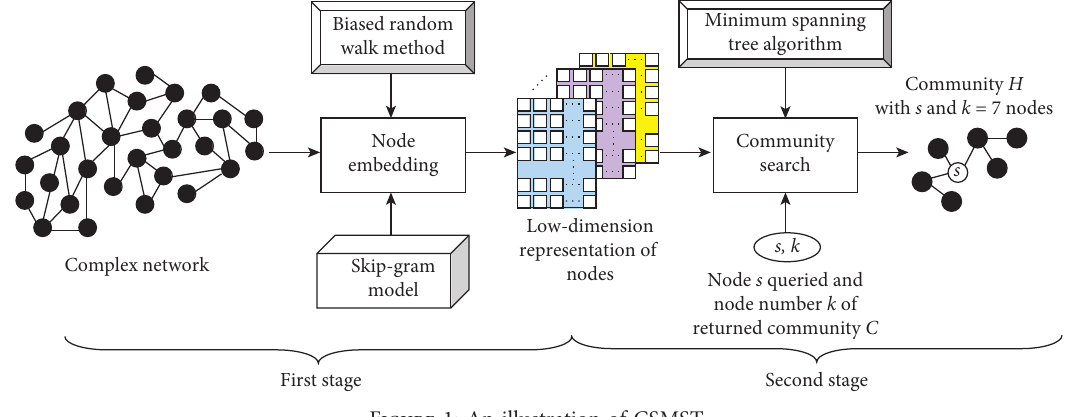
Figure 1: An illustration of